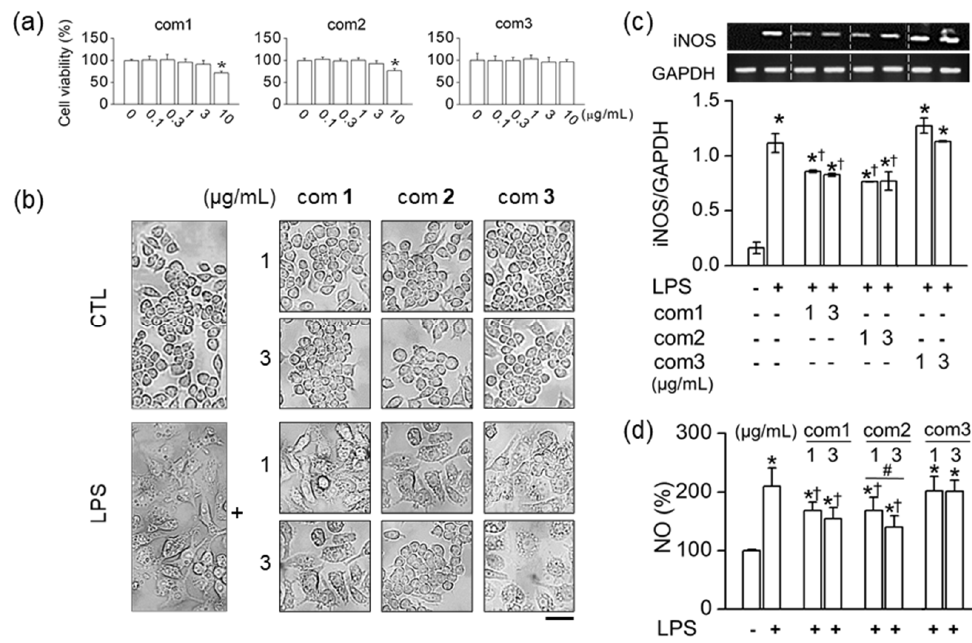
Figure 5. Effects of iridal-type triterpenoids on LPS-stimulated RAW264.7 cells. ( a ) Effect of the triterpenoids at different concentrations on the cell viability. ( b ) Inhibition of LPS-induced macrophage activation by pre-treatment with the triterpenoids. Scale bar, 50 µ m. ( c ) Inhibition of LPS-induced upregulation of iNOS mRNA expression by the triterpenoids. ( d ) Inhibition of LPS-induced increase in NO production by the triterpenoids. ( a , c , d ) * p < 0.05 compared to control (no treatment with LPS); † p < 0.05 compared to LPS alone treatment; # p < 0.05 compared to the 1 µ g/mL of compound 2